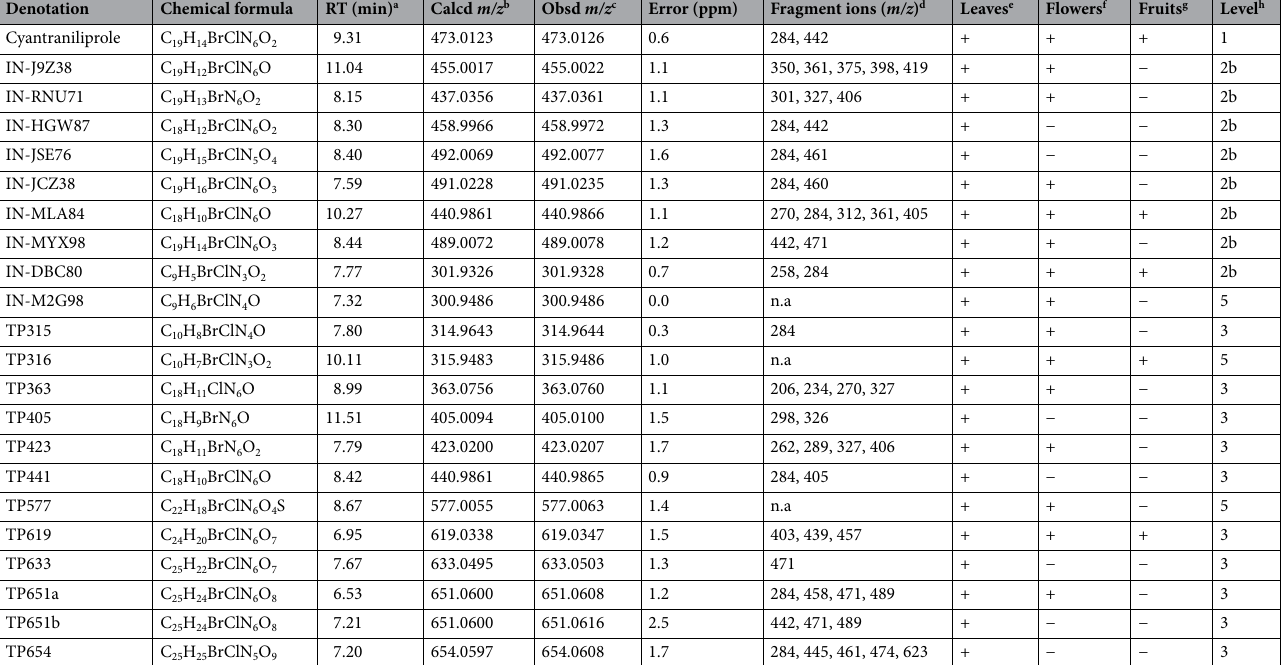
Table 1. Mass-spectral information and proposed chemical formulas of cyantraniliprole-transformation products identified by Compound Discoverer 3.1 and Mass Frontier 8.0 software. n.a: not available, (+): detected, (−): not detected. a Retention time of cyantraniliprole and its metabolites on the UPLC-Orbitrap-MS system. b The accurate calculated masses (calcd m/z ) were obtained with Chemsketch software, version 2019.1.2 (ACD/Laboratories, Toronto, ON). c The observed masses (obsd m/z ) were obtained from a high- resolution MS (Thermo Orbitrap Fusion™ Tribrid™). d The fragments ions acquired using data-dependent MS 2 fragmentation in CID mode of the UPLC-Orbitrap-MS. e,f,g Detected in leaves, flowers, and fruits, respectively. h According to Schymanski et al. 30 Level 1: reference standard, HR-MS, MS/MS, RT confirmed; Level 2b: HR-MS, characteristic fragmentation patterns observed; metabolites previously reported 32 ; Level 3: